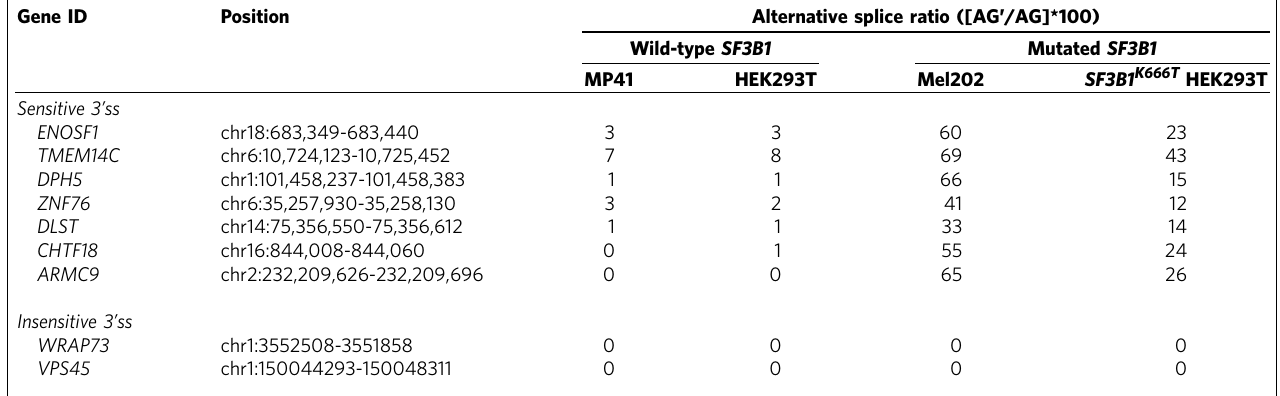
Table 1 | Sensitive and insensitive 3 0 ss selected for validation in cell